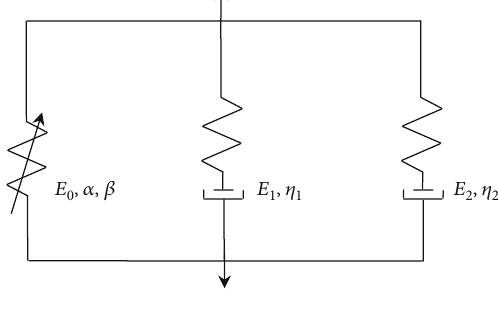
Figure 8: The ZWT